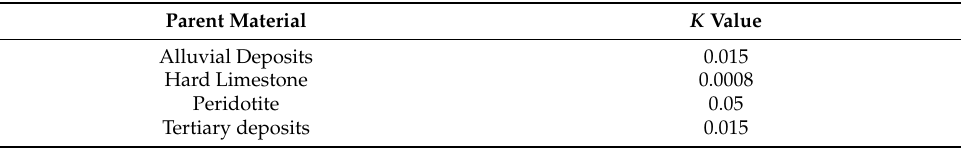
Table 2. Soil parent material and assigned soil erodibility ( K )